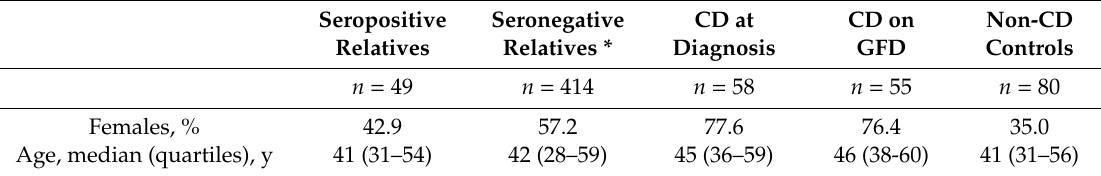
Table 1. Demographicdataonrelativesofceliacdisease(CD)patients,